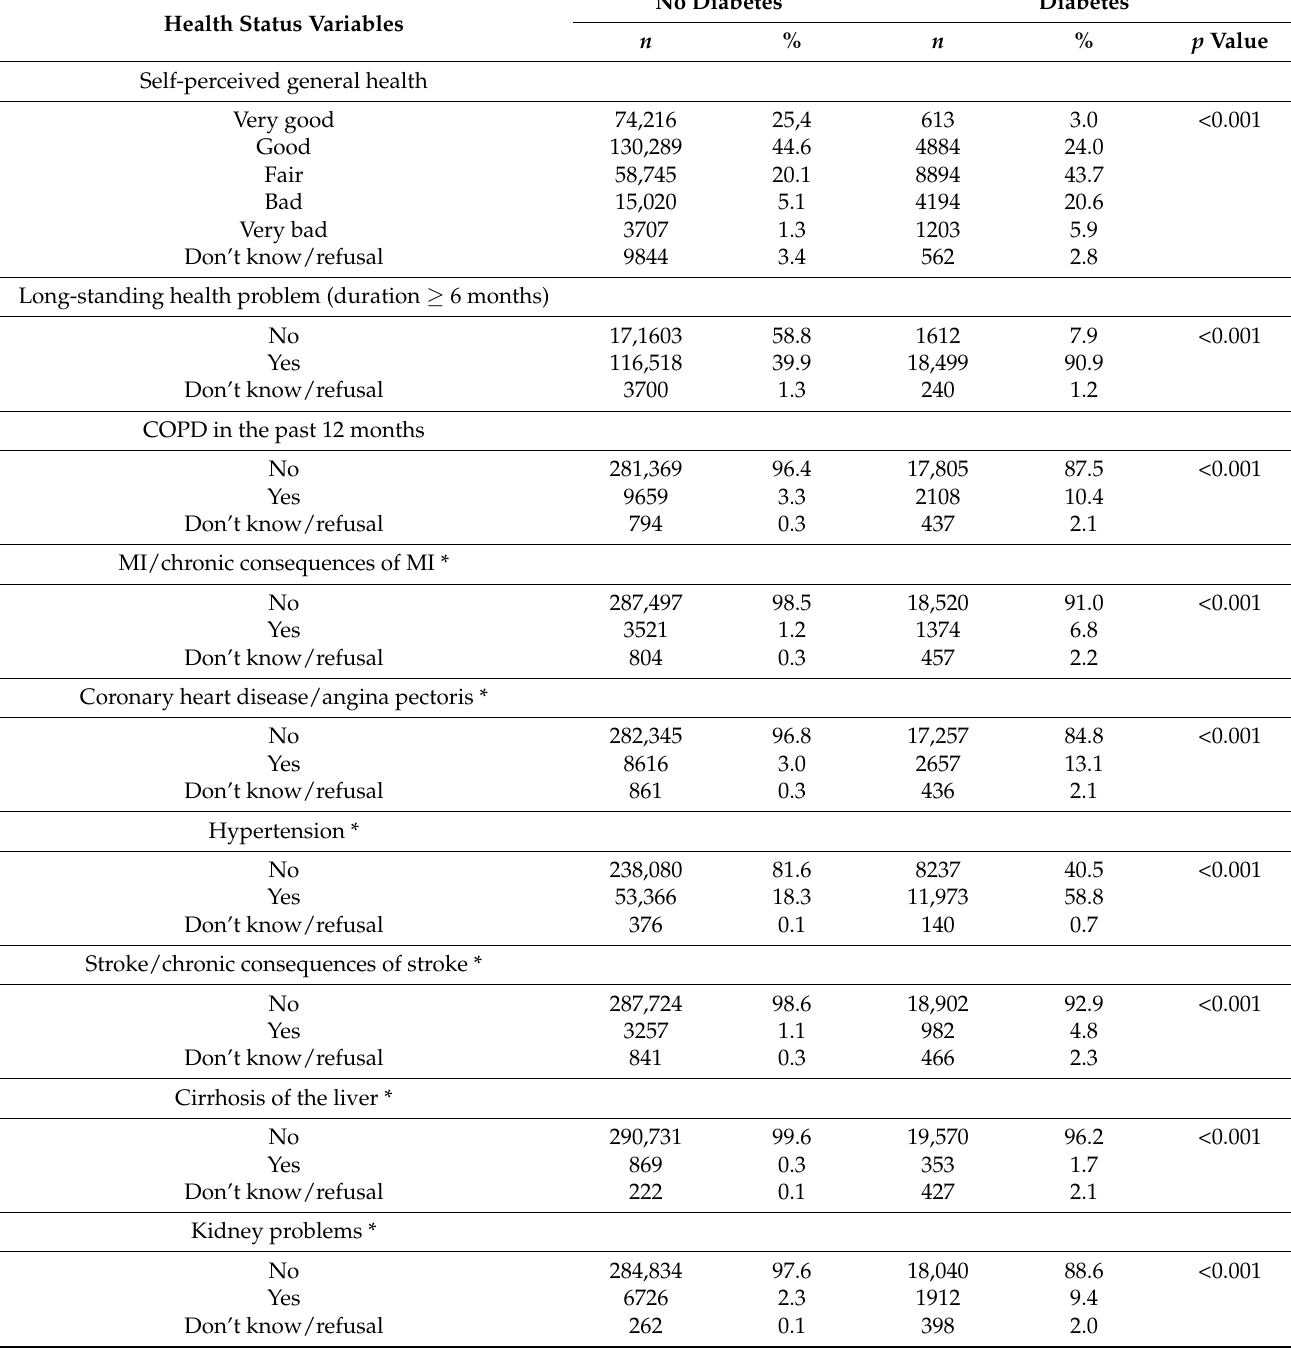
Table 1. Health status variables in the diabetic and non-diabetic